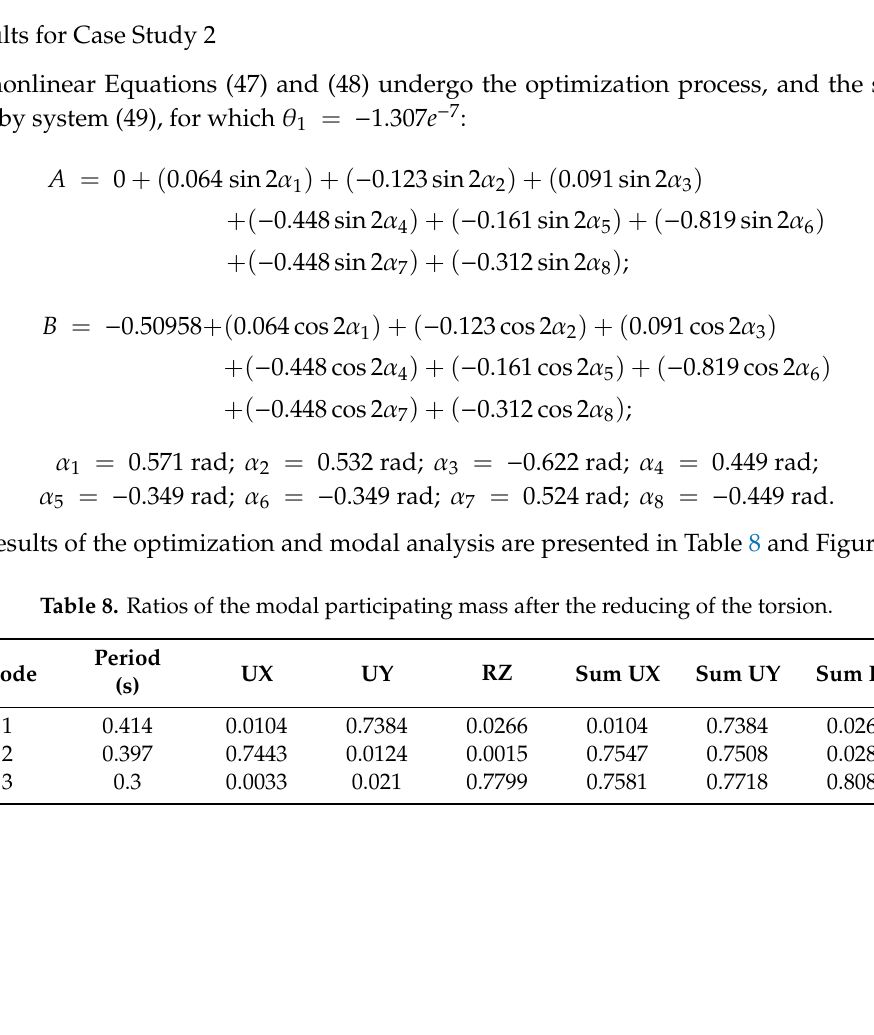
Figure 9. The 1st mode shape for T 1 = 0.433 s: ( a ) plane view, and ( b ) 3D view.